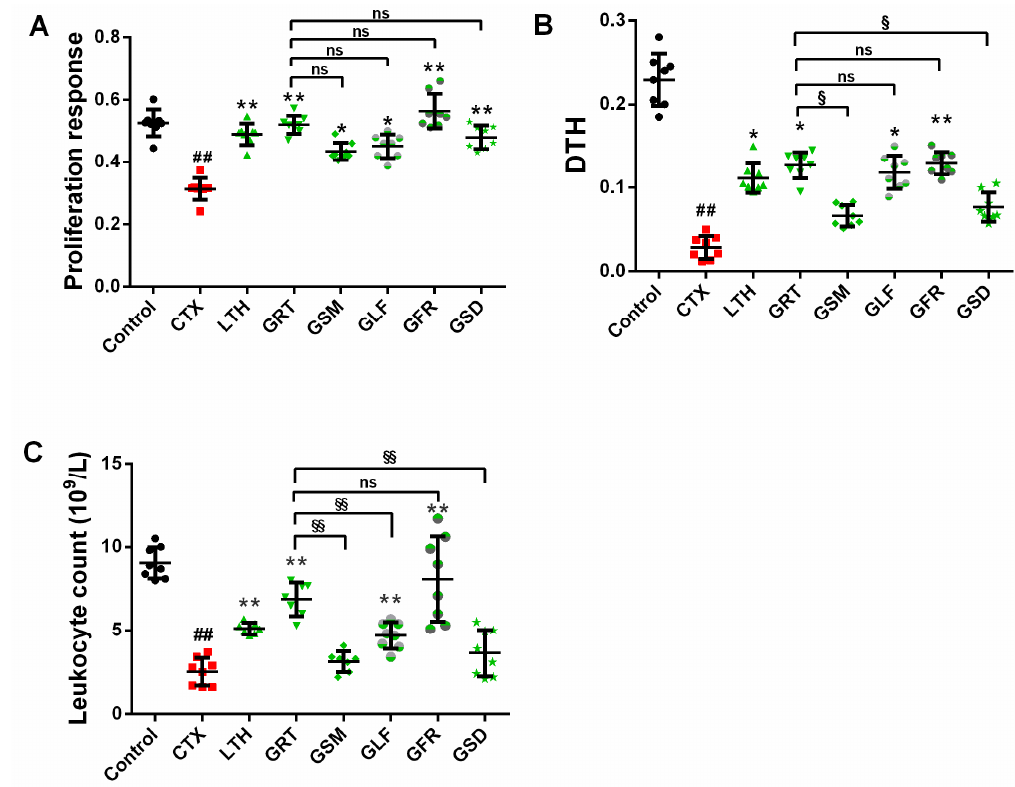
Figure 1. Effect of various parts of ginseng on the ( A ) concanavalin A (ConA)-induced splenocyte proliferation; ( B ) sheep red blood cells (SRBC)-induced delayed-type hypersensitivity (DTH); and ( C ) leukocyte count. The values are presented as mean ± SD, n = 10. ## p < 0.01 compared with the control group. ** p < 0.01 and * p < 0.05 compared with the CTX group. §§ p < 0.01, § p < 0.05, ns p > 0.05 compared with the GRT group.